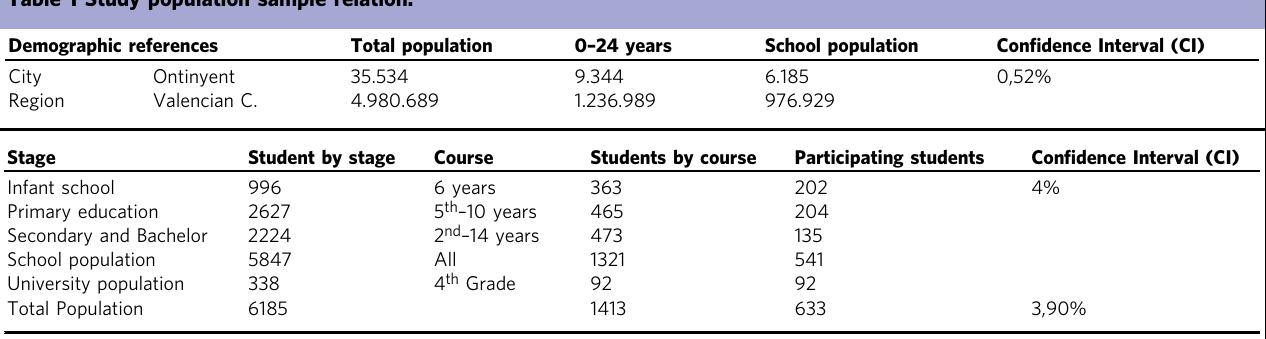
Table 1 Study population sample